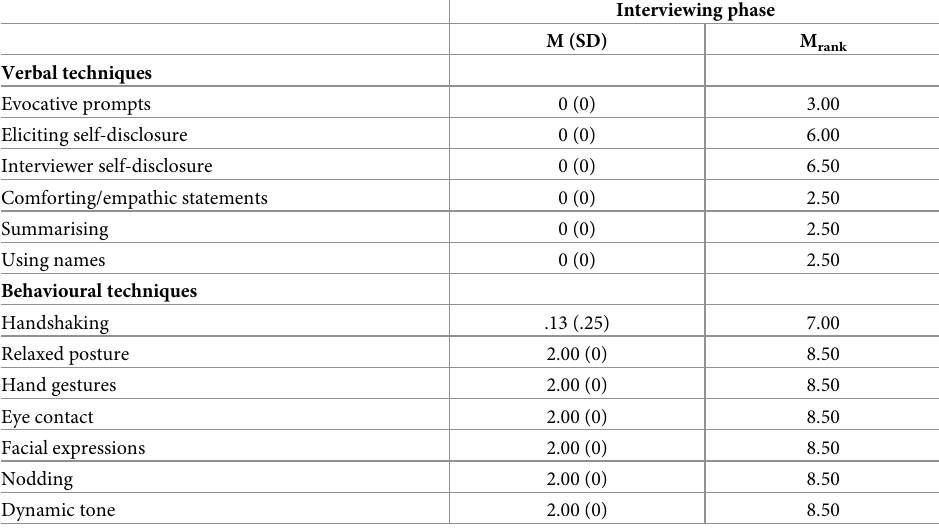
Table 3. Mean coding and Kruskal-Wallis rankings (standard deviations) for the techniques in the behavioural rapport condition.